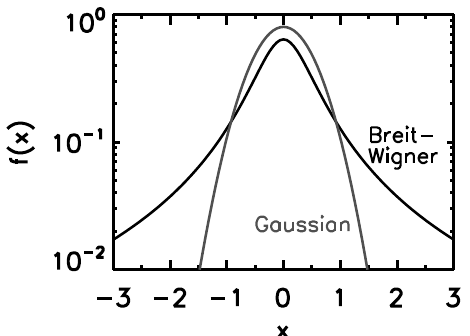
Figure 1. Breit–Wigner distribution for a half-value width of 0 . 5 ( ω 0 = 0 ,ω → x,γ/ 2 = 0 . 5 in Eq. 11) in black and Gaussian distri- bution with a standard deviation of σ = 0 . 5 (in gray).